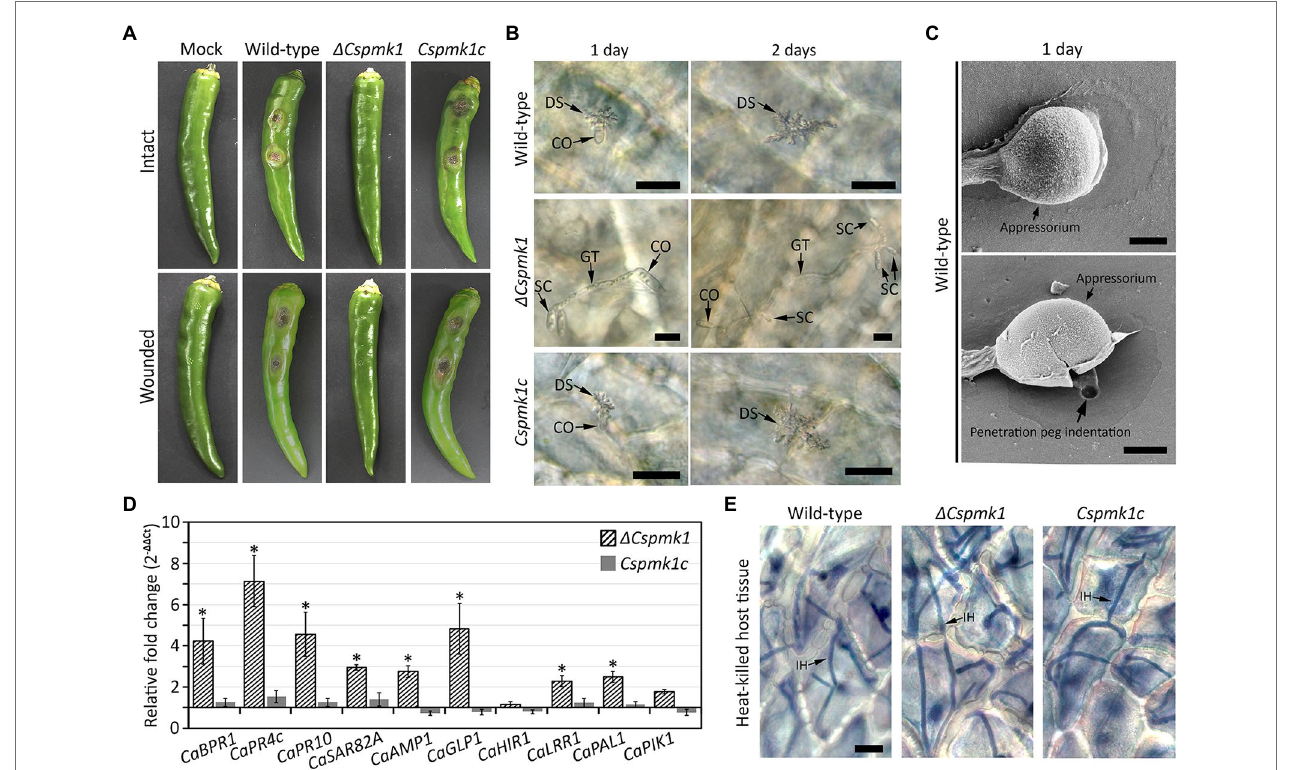
FIGURE 6 | (A) CsPMK1 is critical for pathogenicity. Conidial suspensions (10 6 ml − 1 ) were inoculated into intact and wounded healthy pepper fruits, and incubated in humid plastic boxes at 25 ° C. Photographs of infected intact and wounded pepper fruits were taken after 9 and 6 days, respectively. (B) CsPMK1 is critical for appressorium formation on plant surface. Conidial suspensions (5 × 10 4 ml − 1 ) were inoculated into intact pepper fruits and incubated in a humid plastic box at 25 ° C. Host plants infected by wild type and Cspmk1c exhibited dendroid structures in the cuticle layer. However, the Δ Cspmk1 failed to develop appressorium. Scale bar, 20 μ m. (C) Scanning electron microscope (SEM) images of wild-type appressorium and associated biological materials on pepper fruit surface after 1 day. The upper and lower panel shows treatment with 5 and 10 min sonication. Scale bar, 2 μ m. (D) CsPMK1 is involved in the suppression of expression of